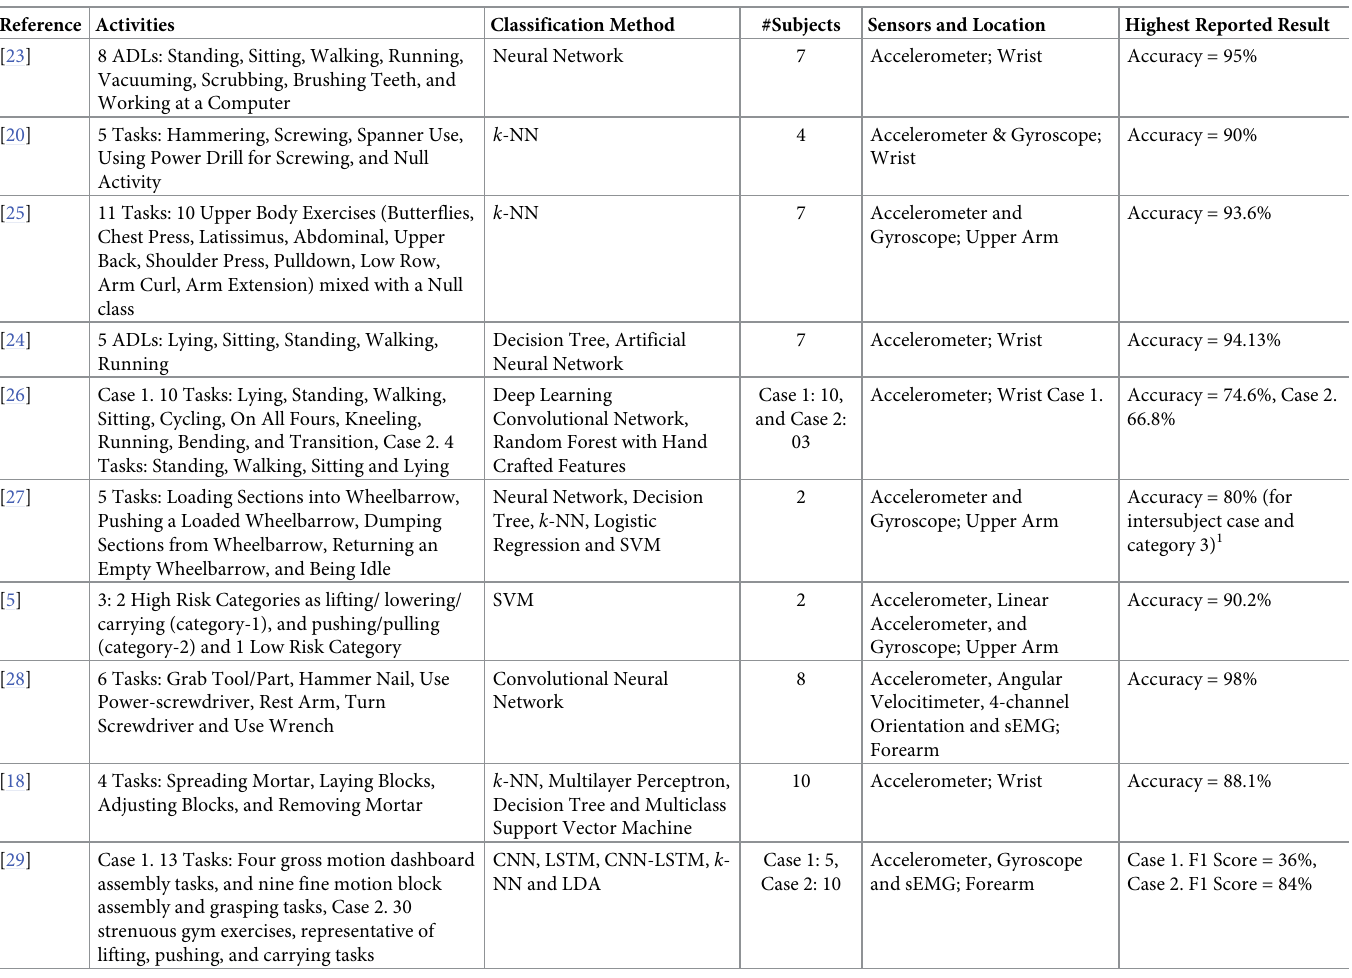
Table 1. Activity recognition studies using a single sensor worn on upper